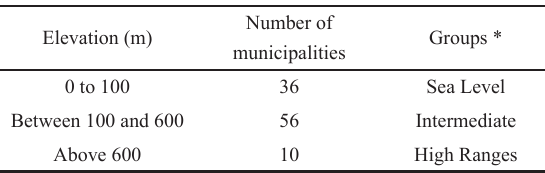
Variation in elevation, number of municipalities and groups related to Melipona scutellaris (Apidae: Meliponina) found in the state of Bahia,